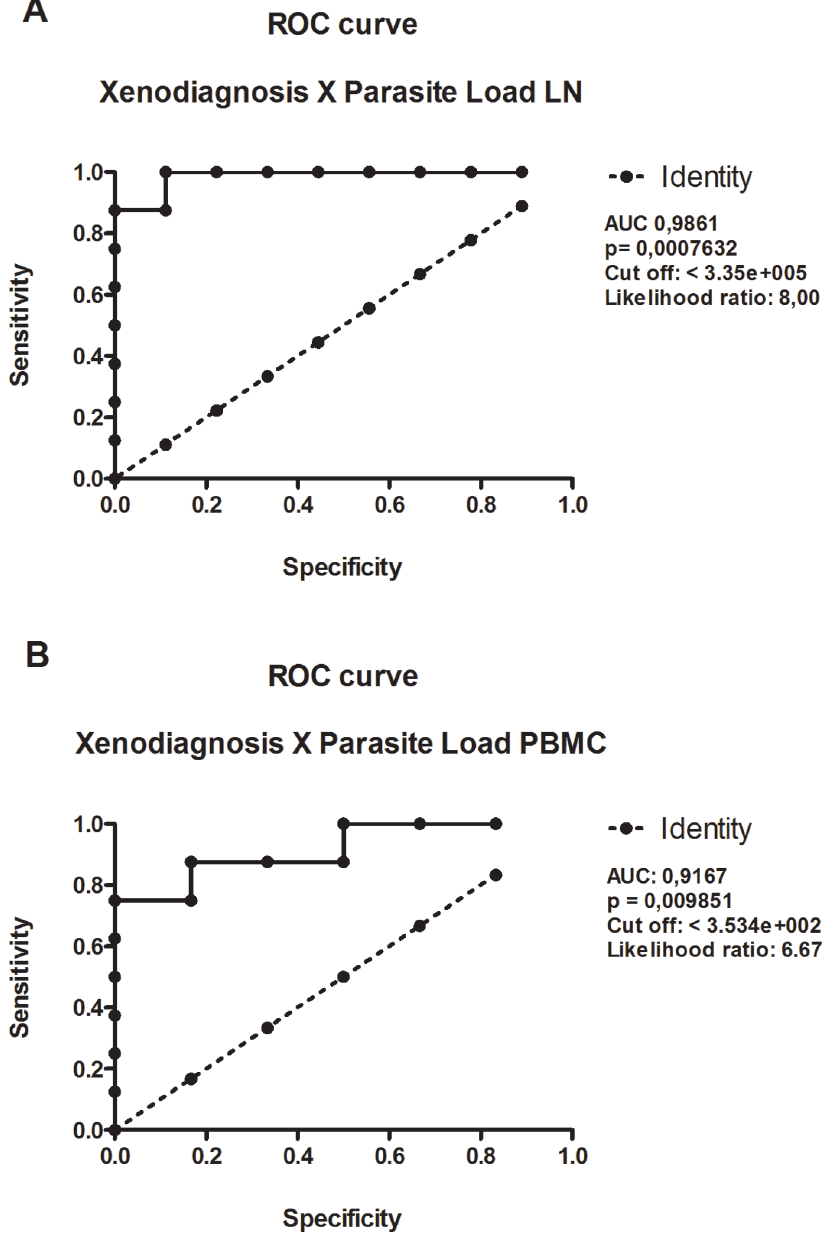
Figure 3. ROC curve of parasite load threshold levels predicting xenodiagnosis positivity. A ROC curve was built using data regarding parasite load levels in lymph nodes (A) or PBMC (B) against the results of xenodiagnosis from 30 dogs infected with Leishmania infantum-chagasi plus five pairs of Lutzomyia longipalpis salivary glands, 450 days post infection.